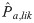
C-score indices of constraint are qualitatively similar to Jaccard and PSadd indices of repeatability when simulations have a constant size of mutational target (A), but differ when simulations vary in the size of mutational target (B).P^a,lik shows qualitatively similar patterns to the C-scores, with a decreasing proportion of the genome accessible to adaptation occurring in scenarios with higher C-scores and higher constraints. In panel A, all runs have ns = gs = 100 loci, with u large effect loci and (100 − u) small-effect loci. In panel B, there are 10 large-effect loci, and v small-effect loci. In both scenarios, simulations were run with N = 10,000 individuals in each patch, recombination rate of r = 0.5 between loci, and per-locus mutation rate = 10−5. The calculation of Chyper is based on categorizing genes as adapted when FST > 0.1, while the calculation of Cchisq is based on FST standardized by subtracting the minimum value and dividing by the maximum within each lineage.